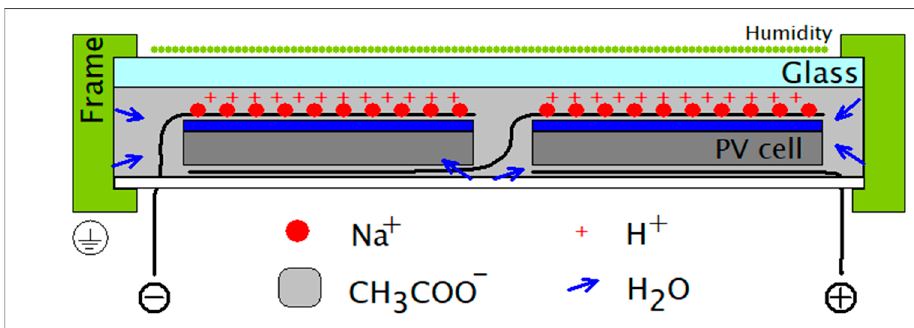
Figure 2. PID polarization scheme.